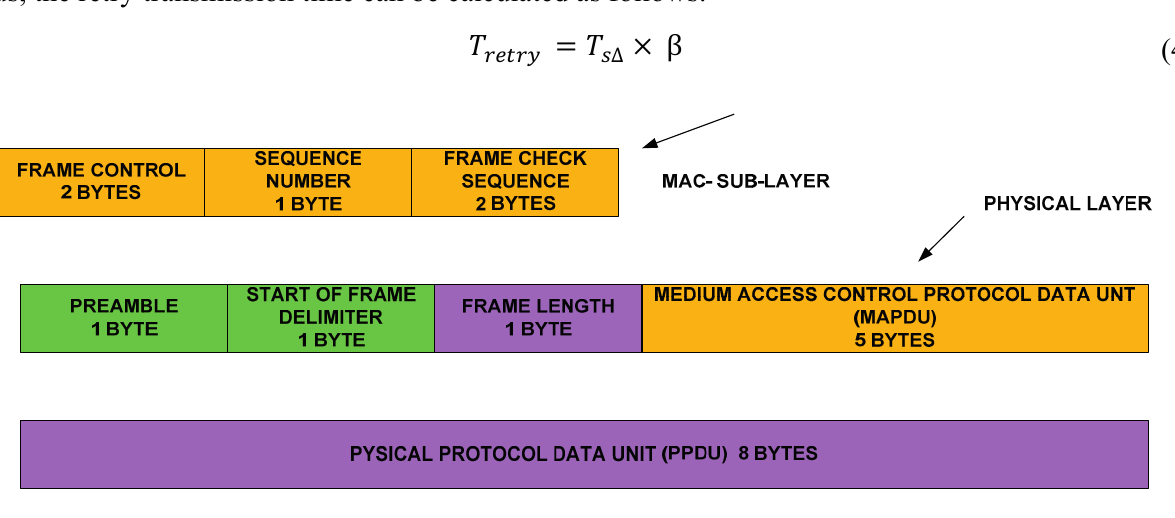
Figure 3. Acknowledgement data frame